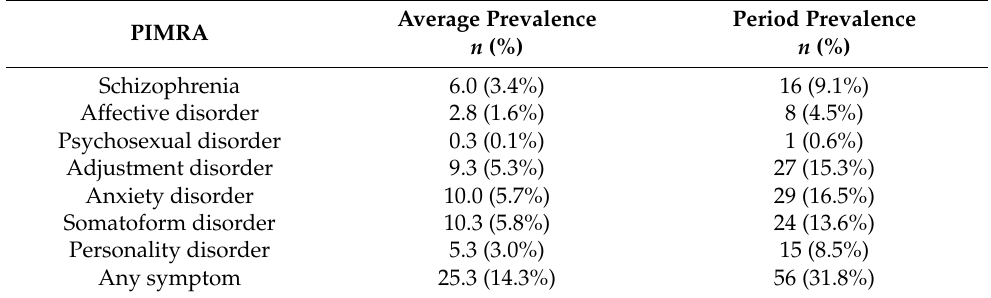
Table 2. Four-wave prevalence and period prevalence of PIMRA psychiatric symptoms ( n = 176). Average Prevalence PIMRA n